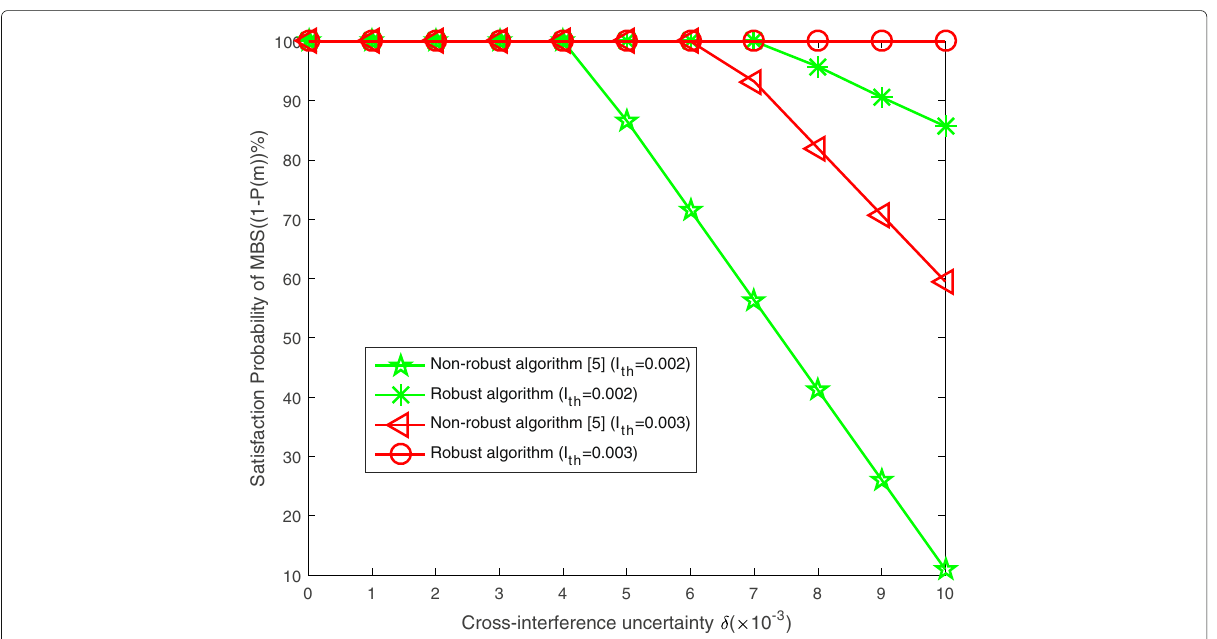
Fig. 6 Outage probability at MU-Rx between robust and non-robust algorithm under different interference perturbation δ